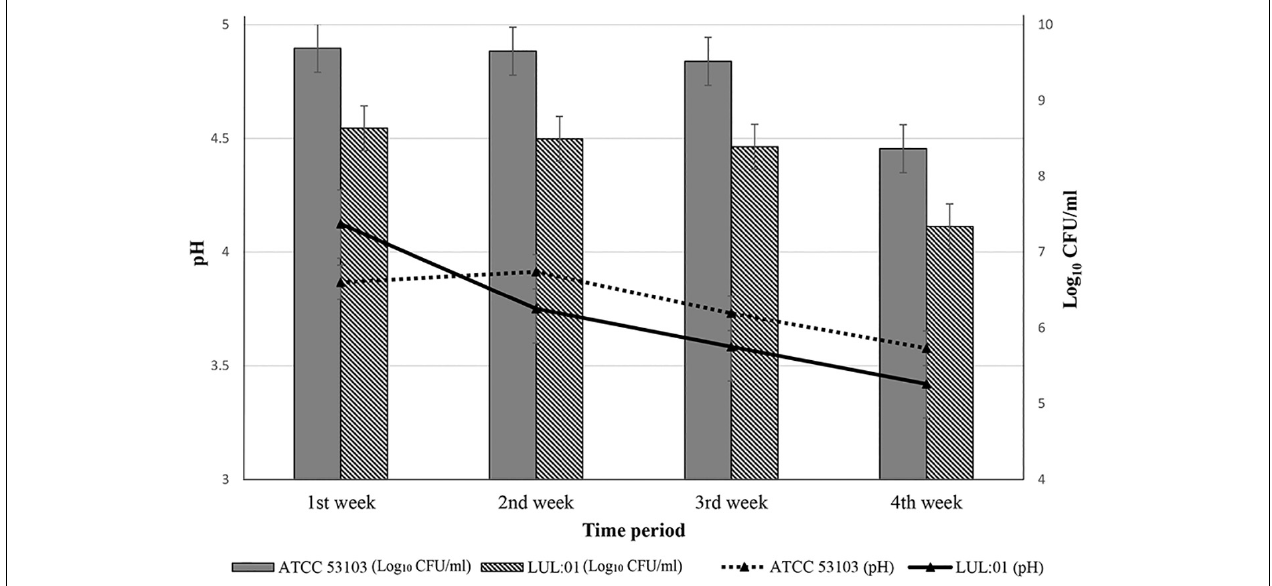
FIGURE 4 | Preparation of fermented milk using the most potential strain Lacticaseibacillus paracasei LUL:01, compared with the reference type strain L. rhamnosus (ATCC 53103). The changes in the pH and viable count during the storage period of fermented milk (28 days at 4 ◦ C). The variation in the pH and viable count (log 10 CFU/ml) showing in the line and bar graph, respectively. Error bars and standard deviations showed with respect to the mean ± S.D. values of triplicate analyses.